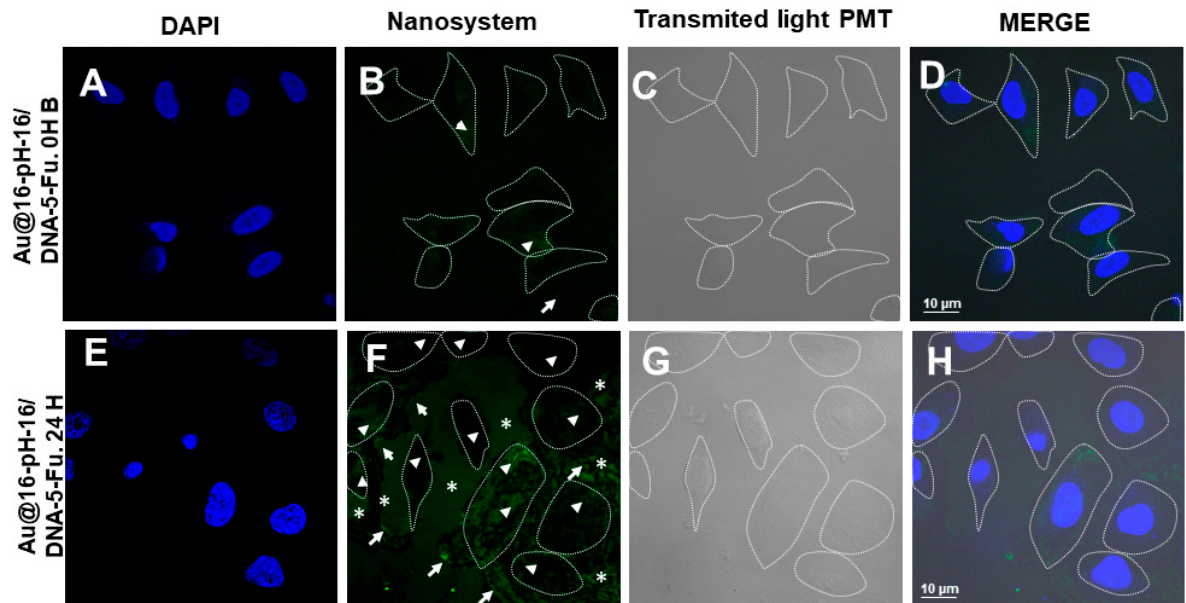
Figure 13. Confocal photomicrographs showing BJ-hTERT cells treated with C 3 Au@16-Ph-16/DNA–5-Fu-compacted nanosystems at 0 h ( A – D ) and 24 h after treatment ( E – H ). ( A , E ) show the cell nuclei labeled with fluorochrome DAPI. The presence of nanoparticles with fluorescence is shown in ( B , F ) and with transmitted light in ( C , G ). ( D – H ) show the result of the merge. Dashed lines mark the cell contours. Arrows indicate nanoparticles on the cell exterior, and arrow heads show nanoparticles internalized in cells. Asterisks indicate possible cytoplasmic remains.